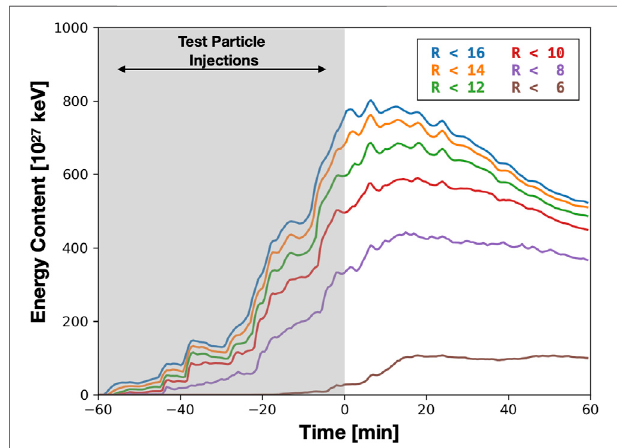
FIGURE 3 | Total energy content from injected guiding center test particles (GCRC) as a function of time for different (cylindrical) radial shells based on equatorial projection of 3 D test particle location. Shaded region denotes period where test particles are being actively injected into the nightside arc at R ≈